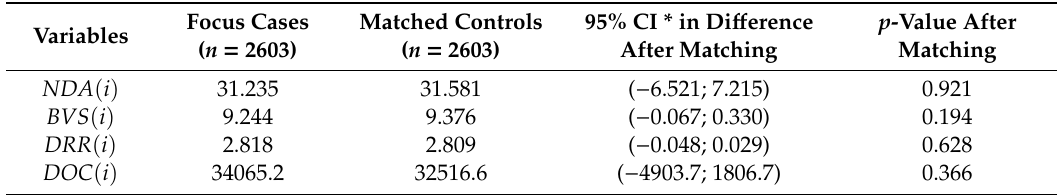
Table 2. Statistics of the Selected Matched Patient